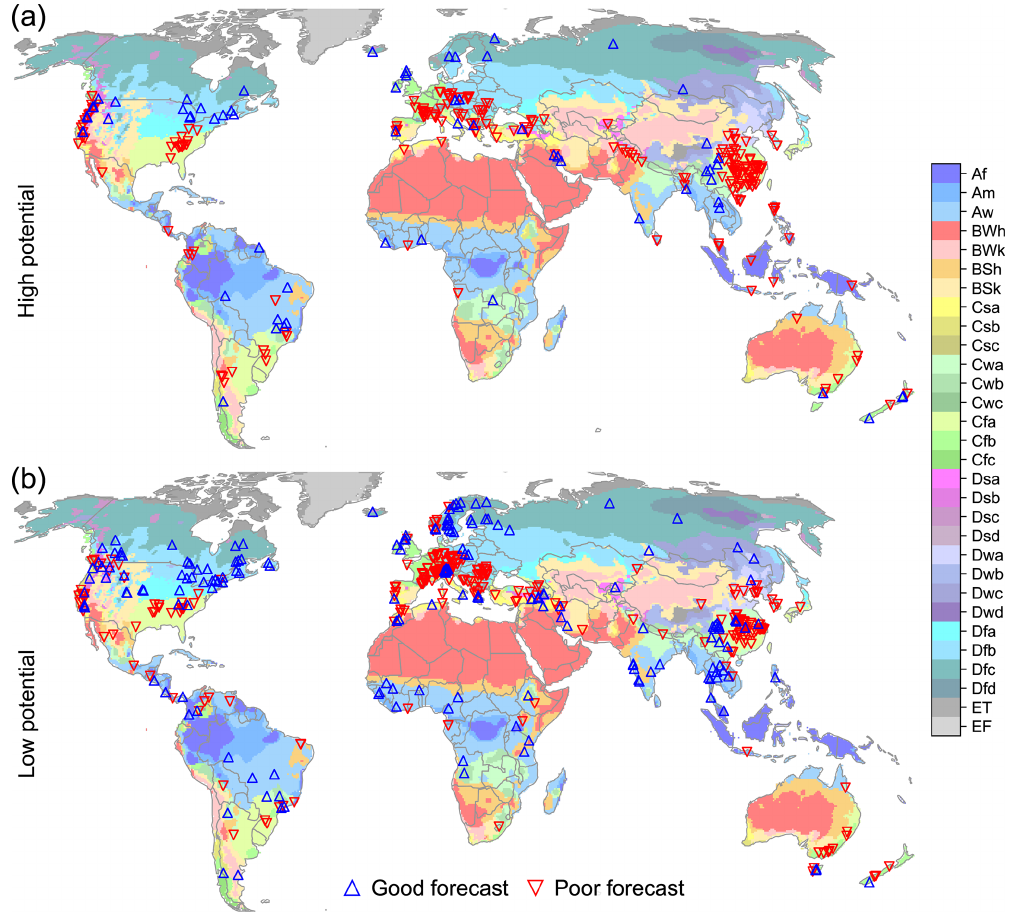
Figure 7. Distribution of dams across climate zones based on their potential to benefit from perfects forecasts. The top (a) and bottom (b) panels represent dams with “high potential” ( I PF > 4 . 7%) and “low potential” ( I PF ≤ 4 . 7%), respectively, while “good forecast” and “poor forecast” represent dams with MdAPE less than or greater than 20%,